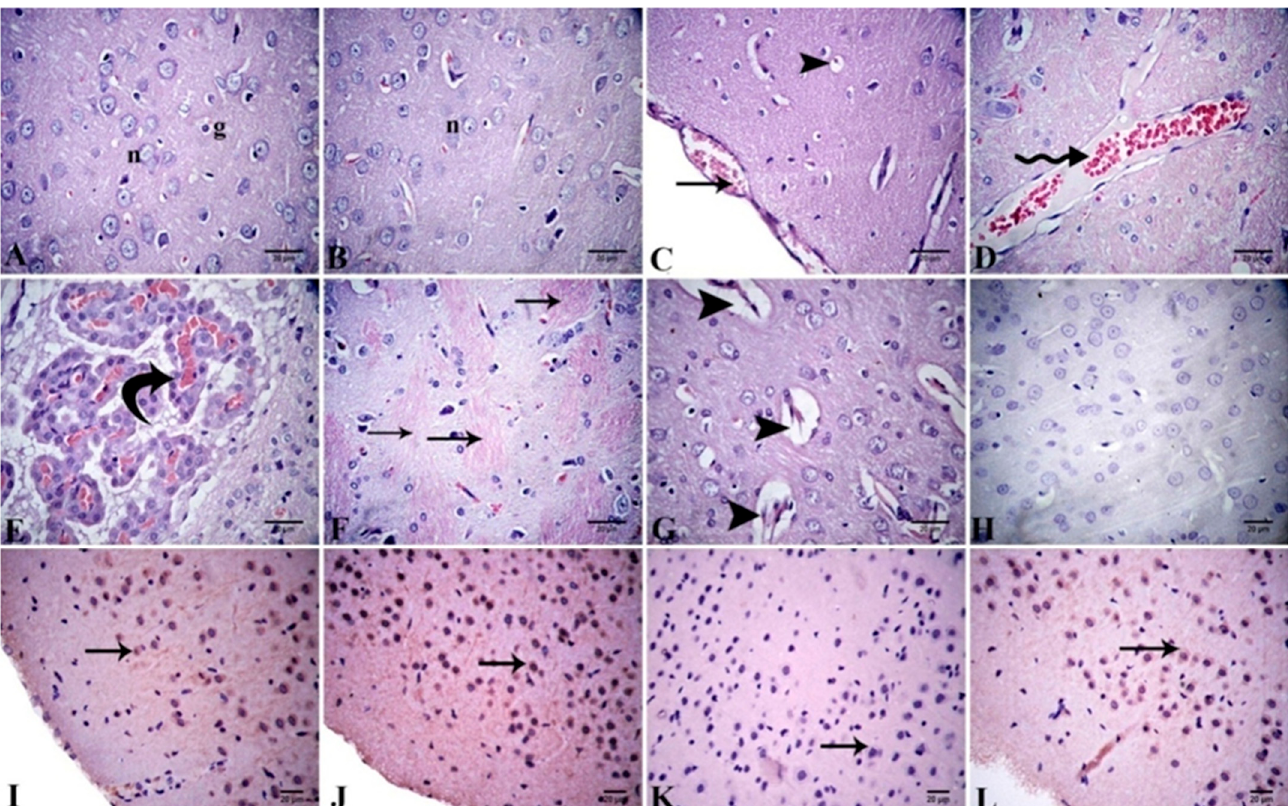
Figure 6. ( A – G ) Photomicrograph of cerebral tissue sections stained with H&E revealing normal histological structure in control ( A ) and Alhagi-administered rats ( B ), neuron (n) and glia cell (g). The lead-intoxicated rats demonstrate congested meninges (arrow) and neuropil vacuolation (arrow head) ( C ), congested blood vessel (zigzag arrow) ( D ), congested choroid plexus (curved arrow) ( E ), and demylinated nerve fibers (arrows) ( F ). The lead + Alhagi-treated rats demonstrate widening in the blood capillaries (arrow heads) ( G ). ( H – L ) Photomicrograph of the cerebral tissue sections exhibiting Bcl-2 immunoexpression (arrows) as the following: negative in the negative control ( H ), moderate in the control ( I ), strong in the Alhagi-administered rats ( J ), mild in the lead-intoxicated rats ( K ), and moderate in the lead + Alhagi-exposed rats ( L ).